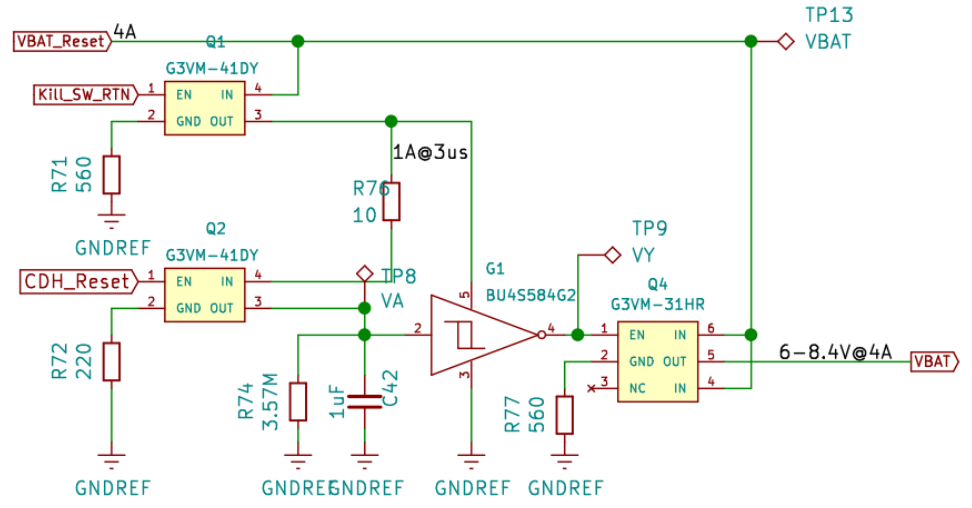
Figure 27. IDEASSat EPS reset circuit diagram.